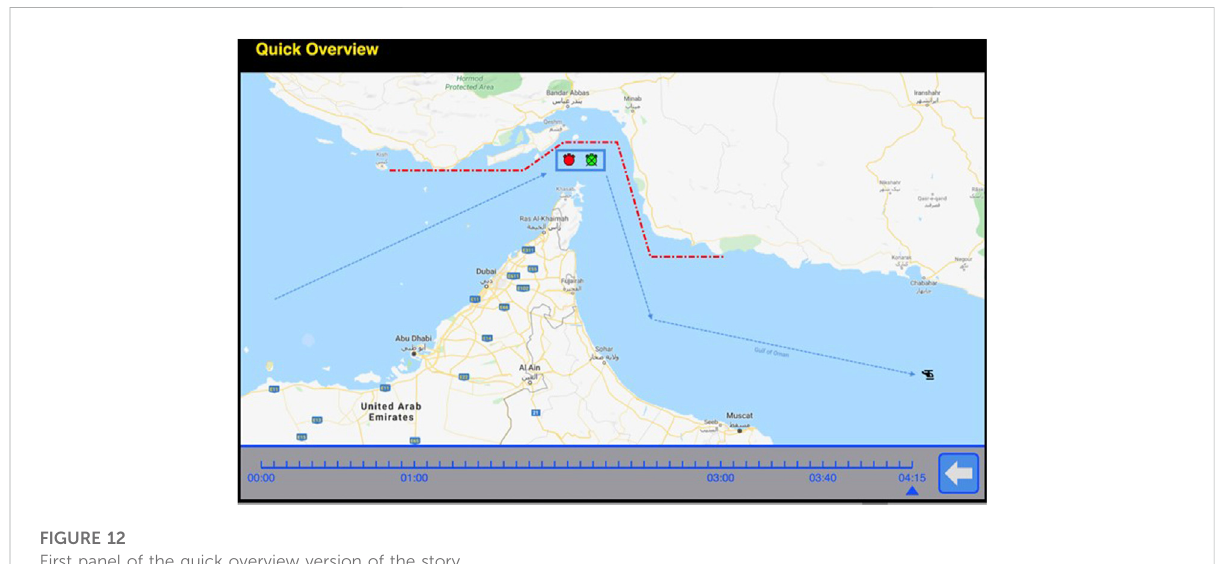
First panel of the quick overview version of the story.